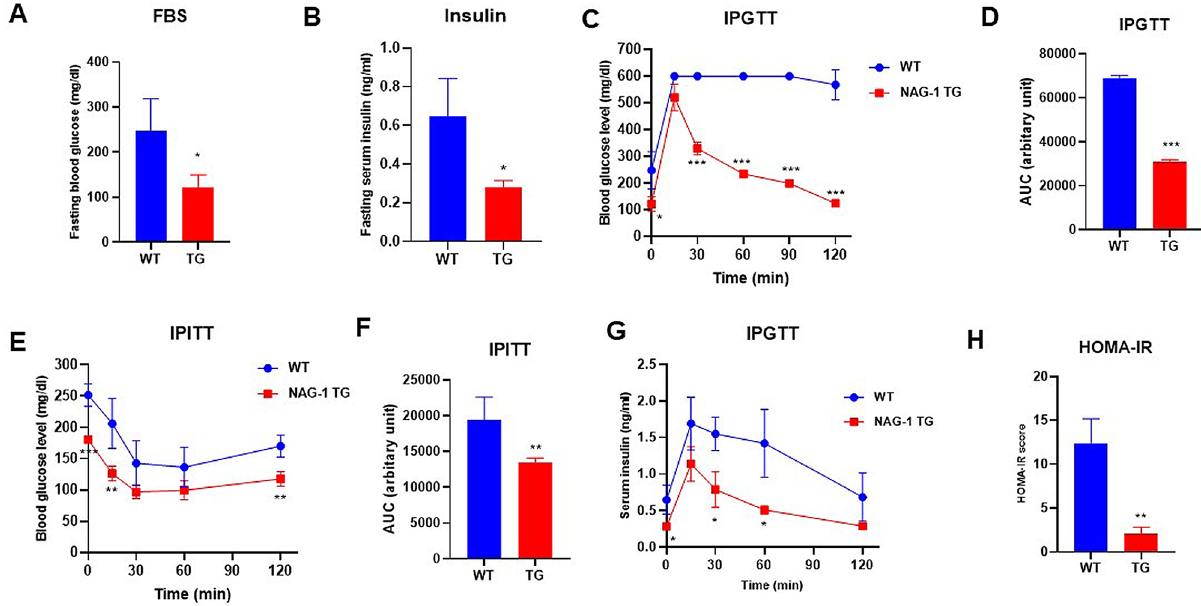
Figure 3. Anti-diabetic effect of NAG-1 in high-fat diet/streptozotocin-induced diabetes mouse model. Mice were allowed to fast for 18 h before the blood sample was collected. ( A ) Fasting blood glucose level and ( B ) fasting insulin level at week 11 before starting the intraperitoneal glucose tolerance test (IPGTT). ( C ) Fasting blood glucose levels at the indicated time points in the IPGTT. Mice were allowed to fast for 18 h before the administration of glucose (2 g/kg body weight). The blood glucose levels were measured at 0, 15, 30, 60, 90, and 120 min post-glucose injection. ( D ) The area under the curve of glucose. ( E ) Fasting blood glucose levels at the indicated time point in the intraperitoneal insulin tolerance test (IPITT). Mice were allowed to fast for 6 h before the intraperitoneal administration of insulin (0.75 U/kg bodyweight). The blood samples were collected to measure the serum glucose at 0, 15, 30, 60, and 120 min post-insulin injection. ( F ) The area under the curve of glucose. ( G ) Serum insulin levels in the IPGTT at the indicated time points. ( H ) Homeostatic model assessment of insulin resistance scores. Data are presented as mean ± standard error of mean. *p < 0.05, **p < 0.01, and ***p < 0.001, compared with the wild-type group (n =